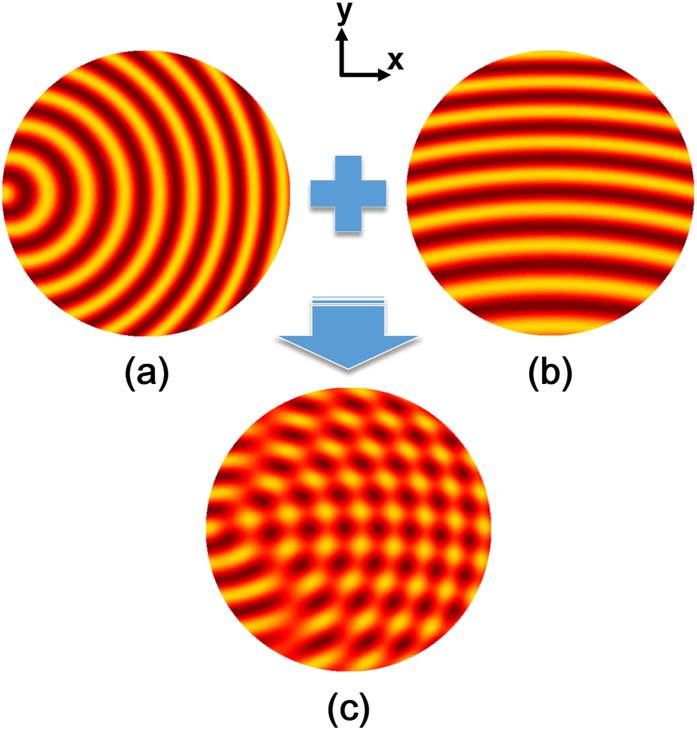
Process of superimposing the impedance modulation at 15 GHz.The original point locates at the left end of the circular area. (a) The impedance pattern for cylindrical carrier waves with Zs_c = j177.1(1 + 0.2cos(1.1k0rs + k0rf)), where ; . (b) The impedance pattern for directional carrier waves with Zs_d = j177.1(1 + 0.2cos(1.1k0y + k0rf)). (c) The hybrid impedance pattern for the dual carrier waves with Zs_h = (Zs_c + Zs_d)/2.